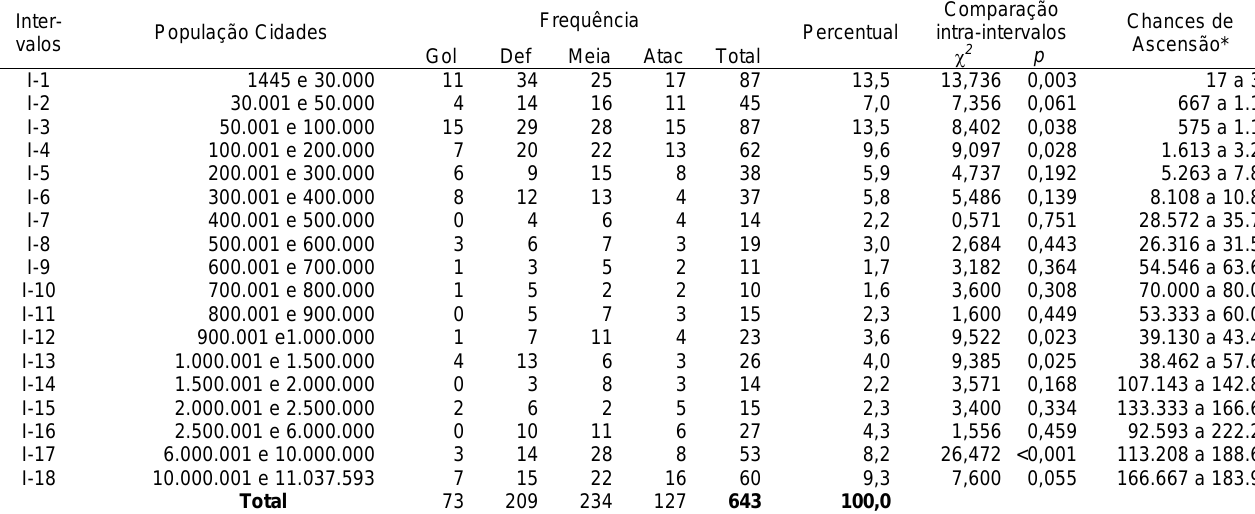
Tabela 1. Frequência dos jogadores nos 18 intervalos populacionais do estudo e as suas chances de ascensão ao alto rendimento no futebol.